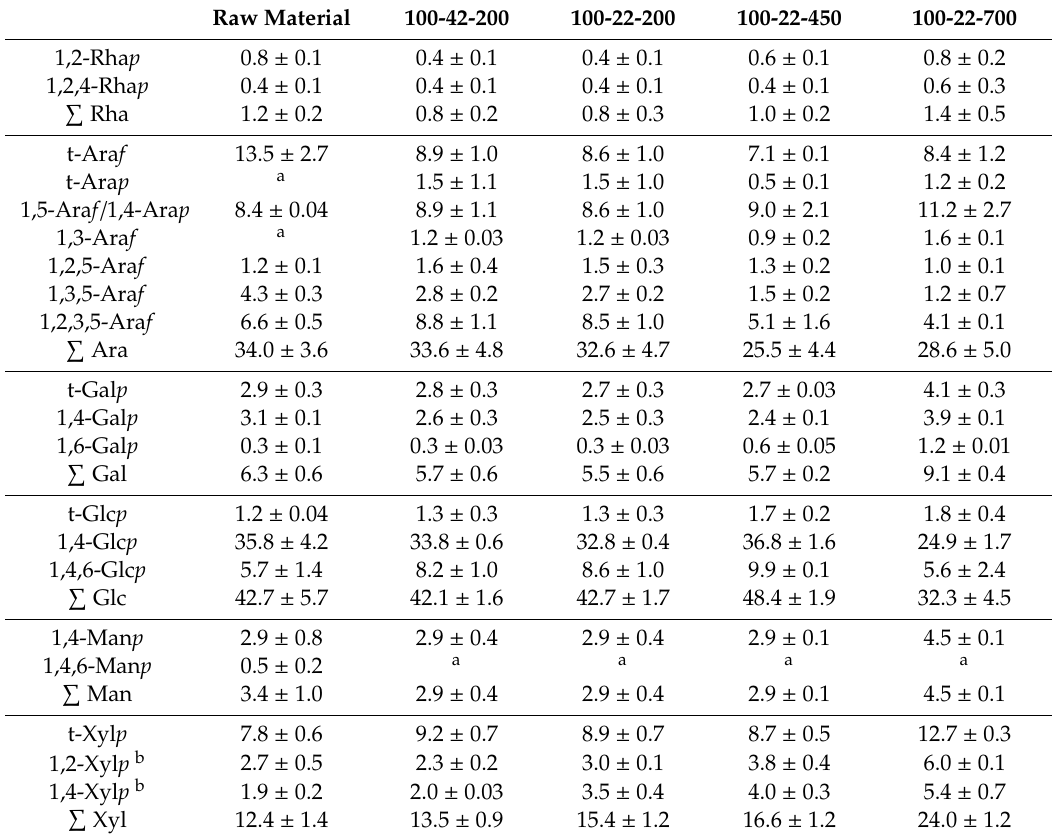
Table 4. Glycosidic linkages (partially methylated alditol acetates; mol%) of insoluble dietary fiber of raw and extruded apple pomace (mean value ± range / 2, n = 2). t: terminal, p : pyranose, f :